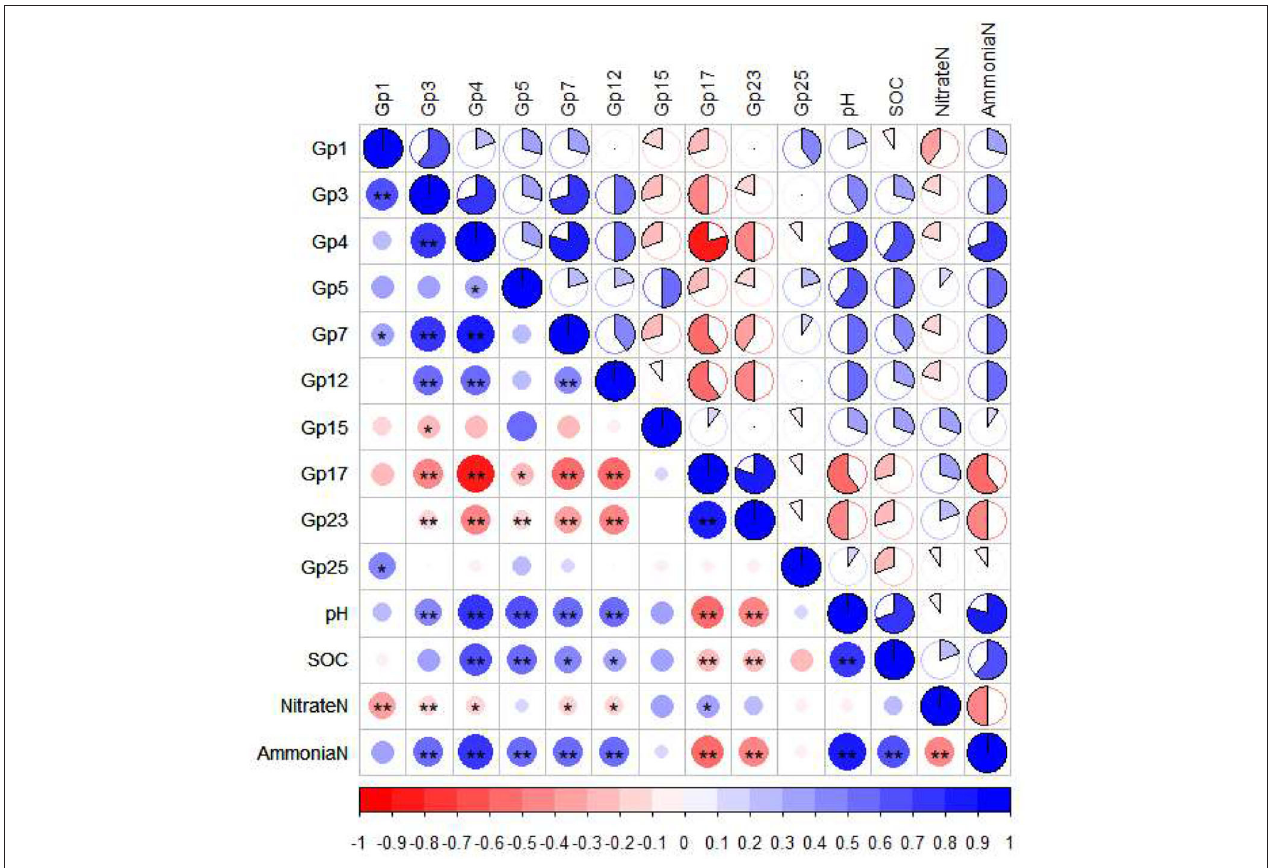
FIGURE 4 | Pairwise Pearson’s correlation matrix of the edaphic factors and Acidobacteria subgroups was shown with heat map, * Significant at the P = 0.05 level, ** Significant at the P = 0.01 level. SOC, Soil organic